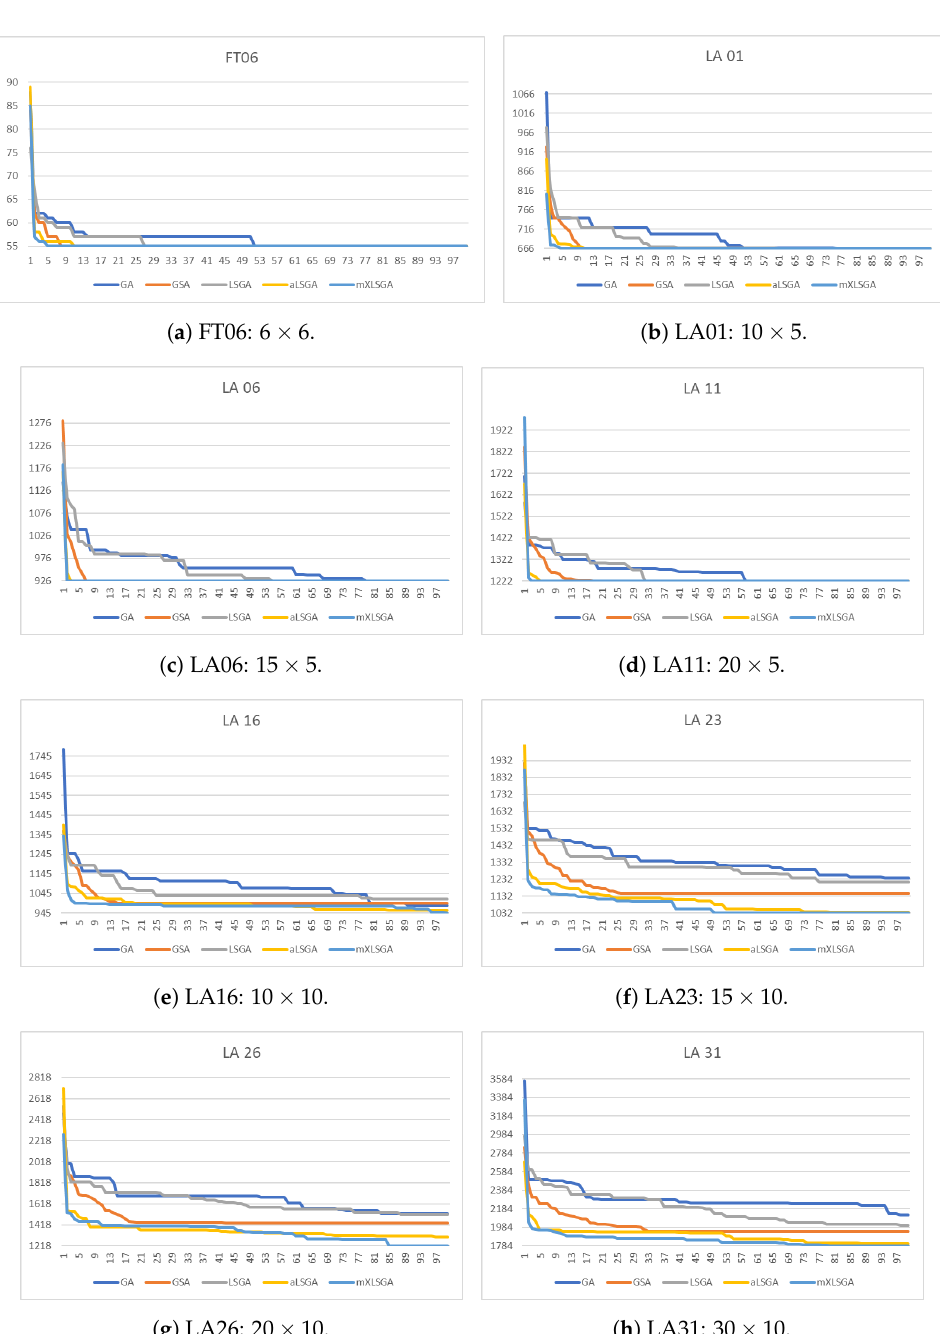
Figure 7. Convergence curves of GA-like methods over 100